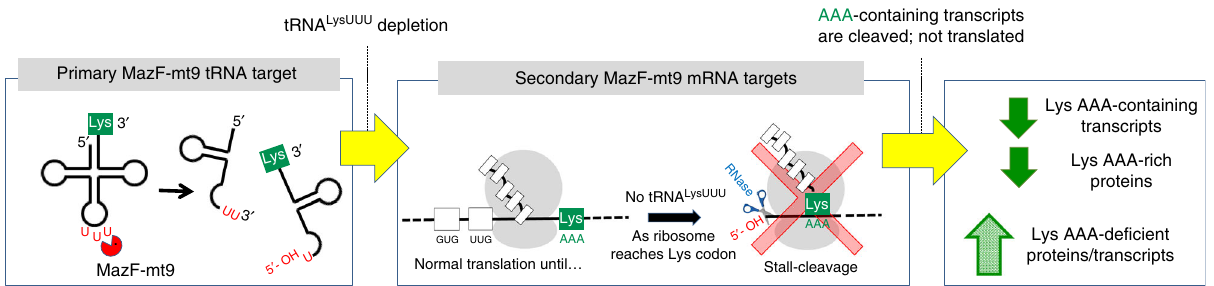
Fig. 9 MazF-mt9 mechanism of action. The toxin controls gene expression through the cleavage of tRNA Lys43-UUU (left panel), causing ribosome stalling and subsequent degradation of the mRNAs by one or more RNases (middle panel). This cooperative action reduces the steady levels of AAA-rich proteins and favors an increase in AAA-de fi cient proteins (right